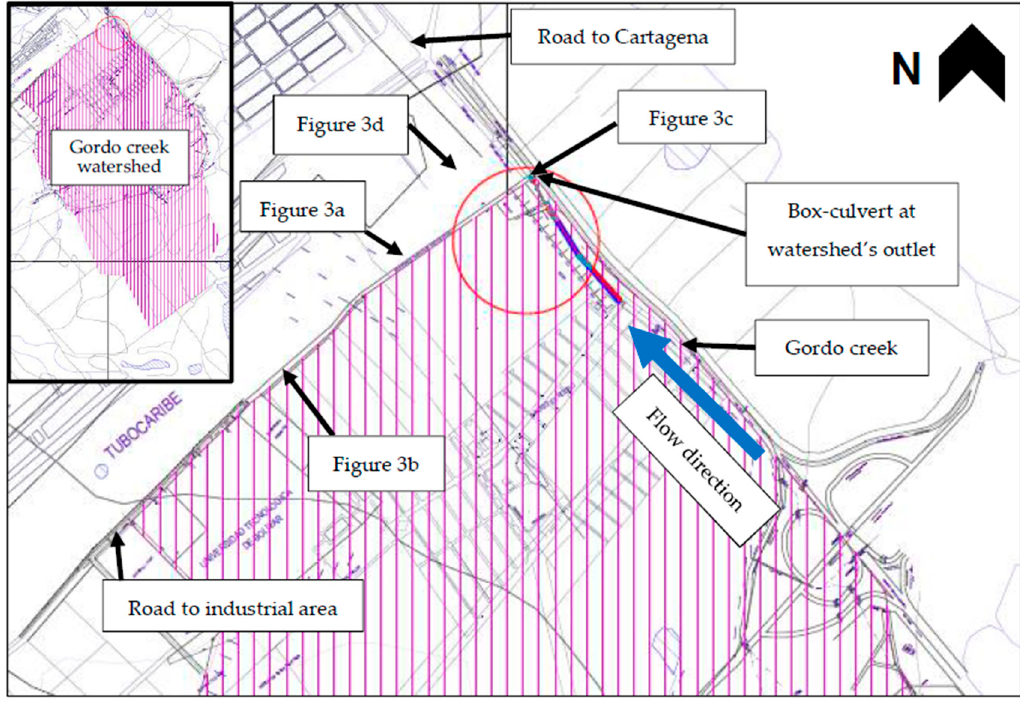
Figure 2. Study area location.